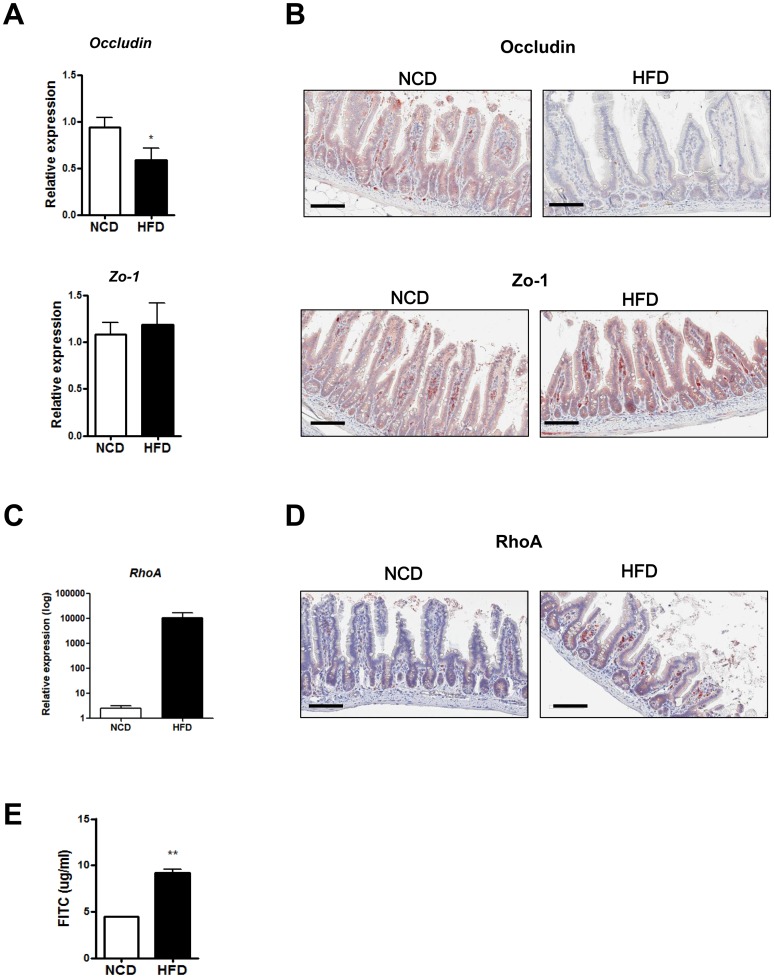
Disruption of the gut barrier in high-fat diet (HFD)-fed mice.(A) RT-qPCR analysis of Occludin and Zo-1 using RNA from the distal ileum of normal chow diet (NCD)- or HFD-fed mice (n = 5 each). (B) Representative immunohistochemistry of distal ileal sections using anti-Occludin or -Zo-1 mAb. (C and D) RhoA expression in the intestine of mice fed NCD or HFD. mRNA expression (C) and representative immunohistochemistry (D) of RhoA in the small intestine. (E) Serum levels of FITC 4 h after oral FITC-dextran administration to NCD- or HFD-fed mice by oral gavage (n = 5 each). Original magnification ×200 for all images. Scale bar, 100 μm. All values are expressed as the means ± SEM. A student’s t-test was used to compare values between two groups. *P < 0.05, **P < 0.01.